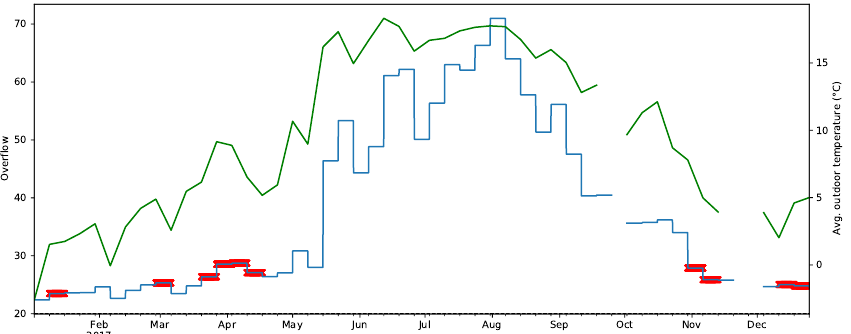
Figure 6. Example of well and sub-optimally performing substations in 2017. Overflow vs. outdoor temperature. Due to missing values, some of the weeks are